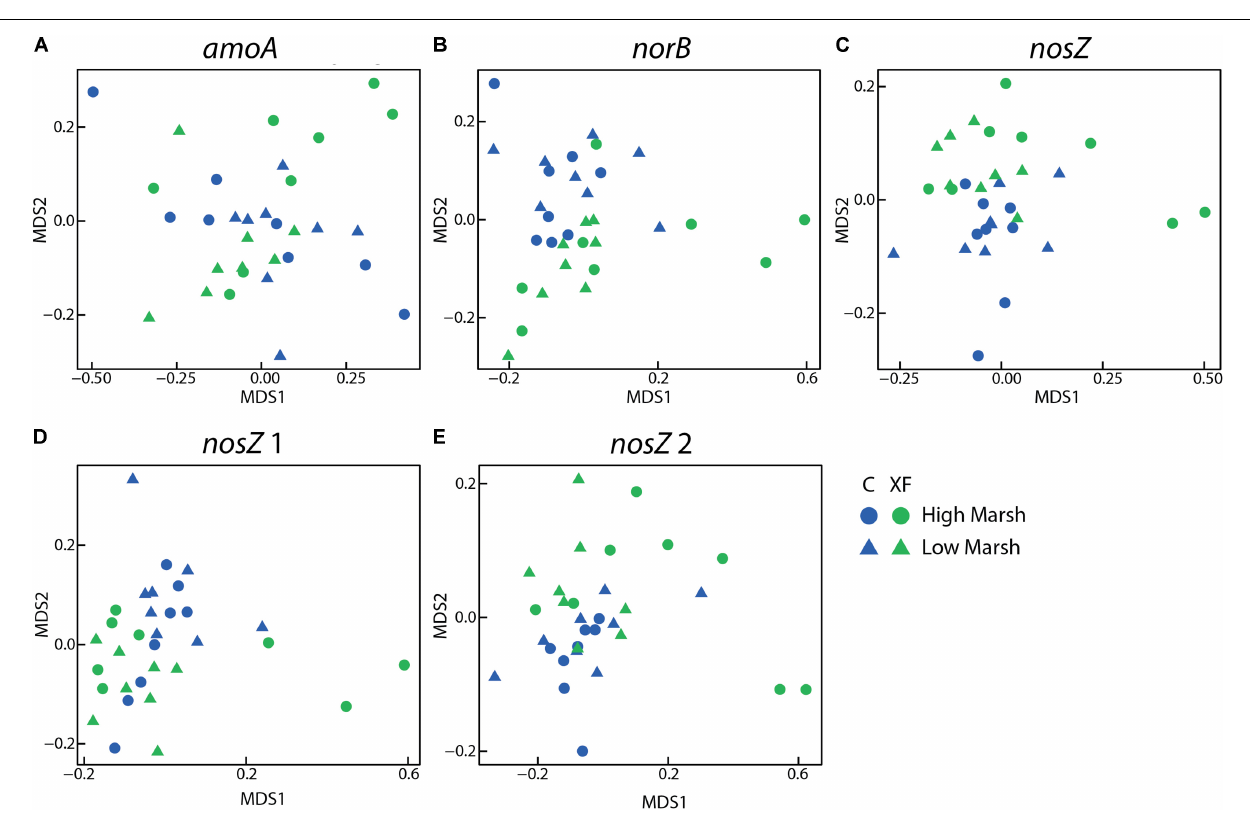
FIGURE 3 | Non-metric multidimensional scaling (NMDS) plots of RFR microarray data for AOA amoA (A) , norB (B) , nosZ (C) , atypical nosZ 1 (D) , and atypical nosZ 2 (E) . All but AOA amoA differ significantly by treatment using adonis. None differ significantly by habitat or depth. Each figure includes eight samples (2 depths × 2 habitats × 2 duplicate cores) per plot and there were four plots (two control and two XF-fertilized